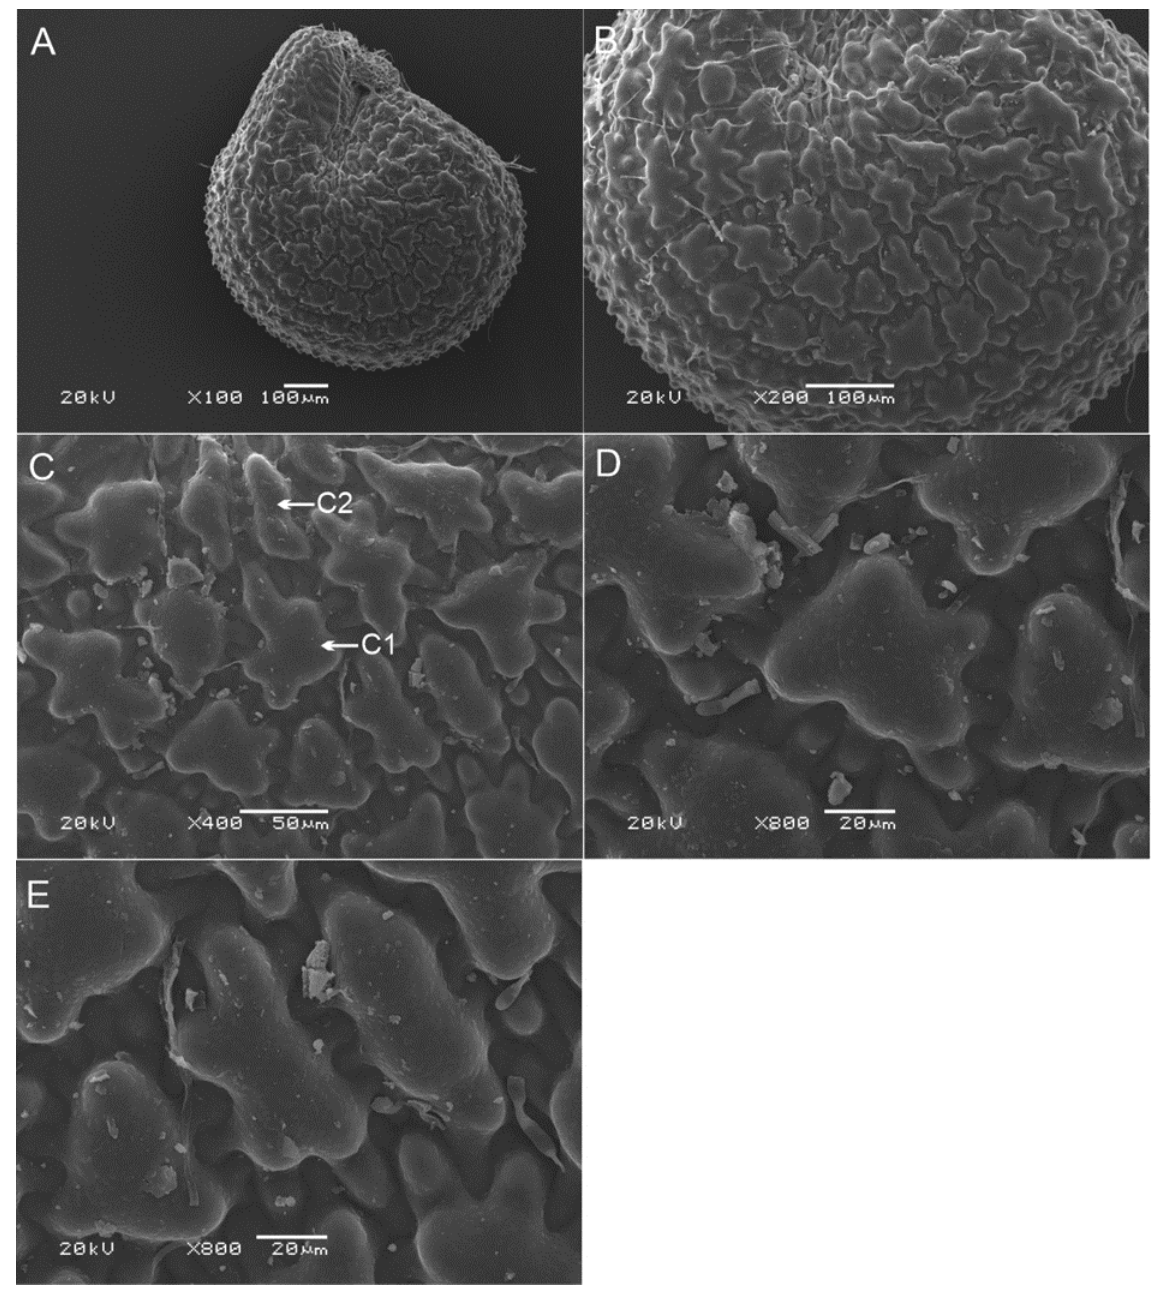
Figure 3 Portulaca granulatostellulata (SEM). General view of the seed ( A ). e seed surface ( B,C ). Isodiametric cell ( C1 ), elongated cell ( C2 ); general view of the cells ( D,E